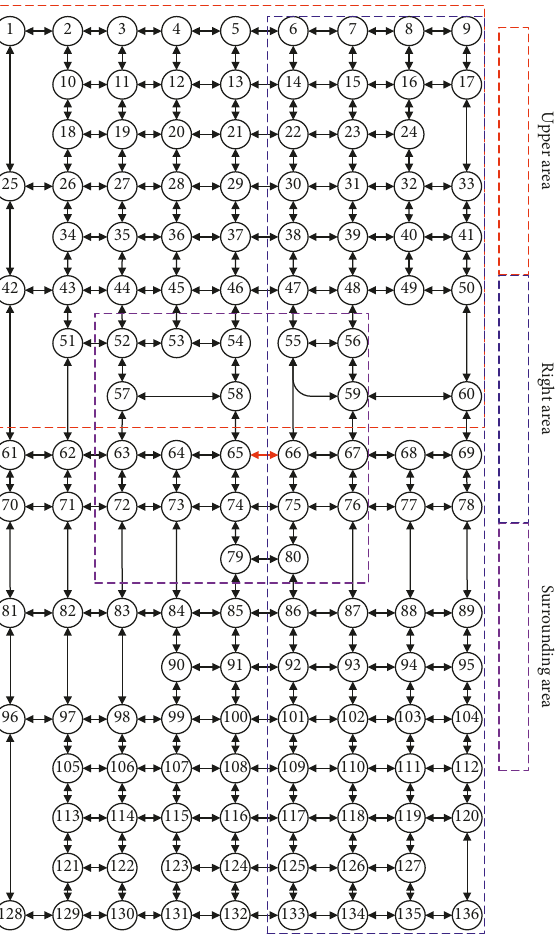
Figure 16: The situation of area division. Figure 17: Subnetwork under different OD